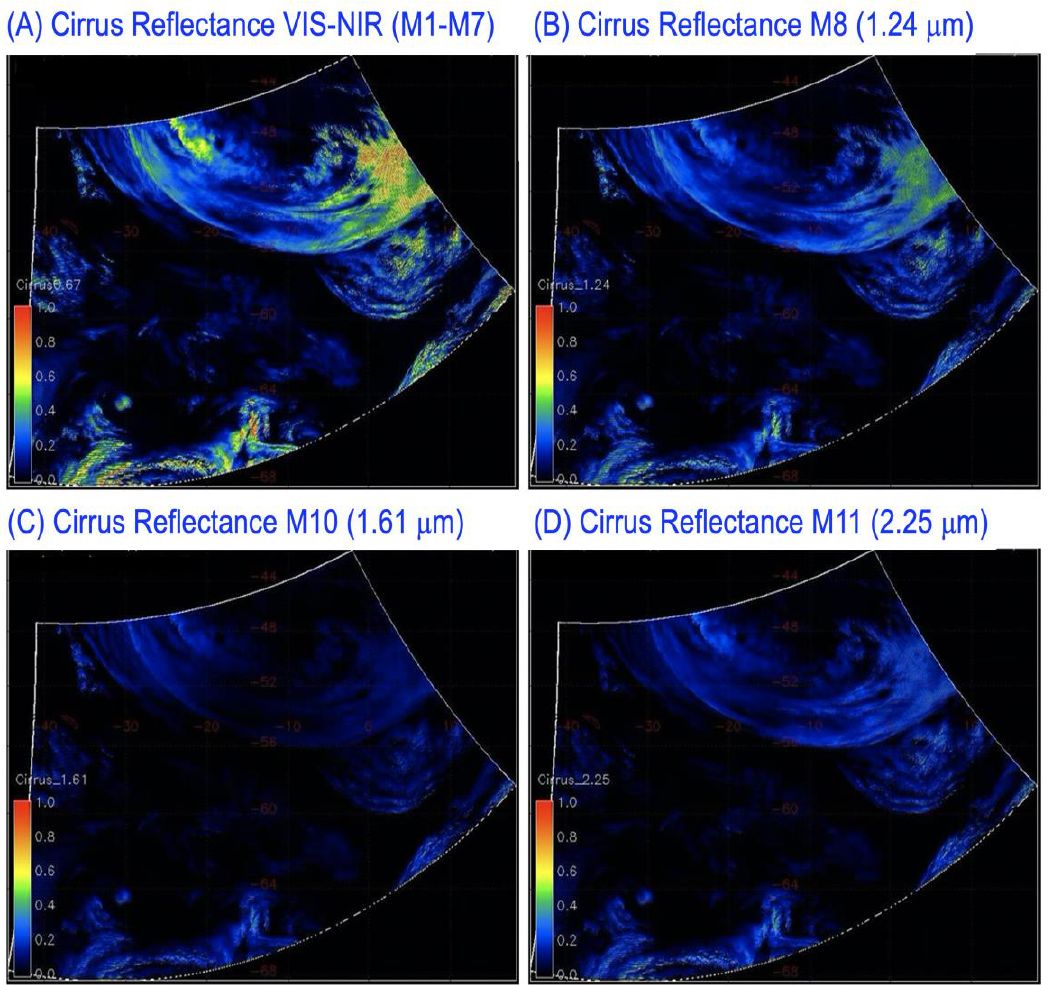
Figure 10. Sample retrievals of cirrus reflectances for VIIRS VNIR channels (M1–M7) ( A ), SWIR channels M8 (1.24 μm) ( B ), M10 (1.61 μm) ( C ), and M11 (2.25 μm) ( D ) for one 6 min VIIRS granule